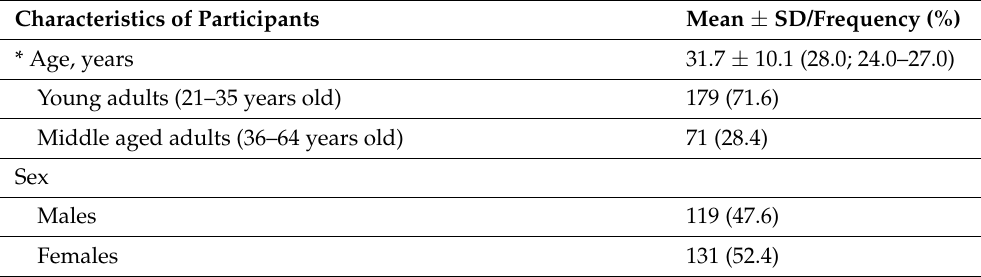
Table 1. Sociodemographic characteristics of the 250 study participants. Characteristics of